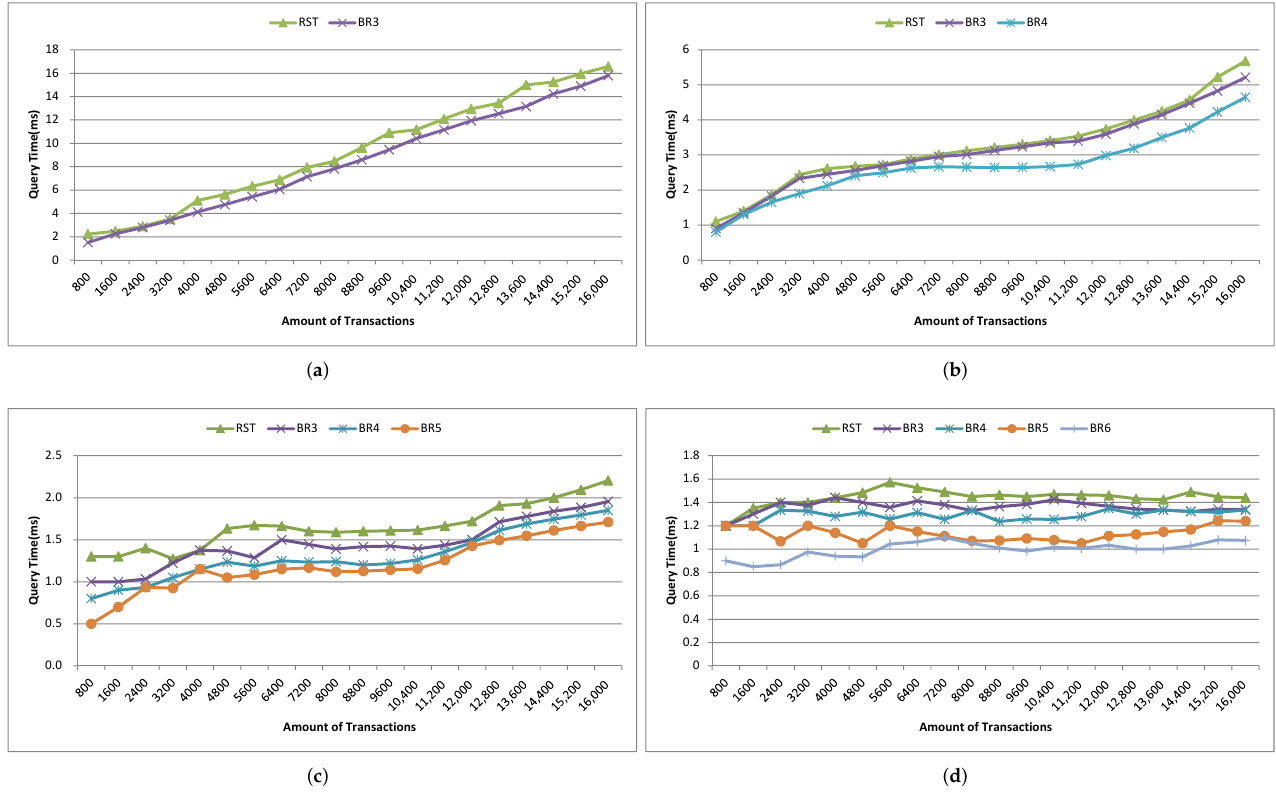
Figure 9. Query time of the amount of branch region query method with different amount of transactions in specified geographic region. ( a ) The query range is geographic region of the 3-byte Geohash encoding. ( b ) The query range is geographic region of the 4-byte Geohash encoding. ( c ) The query range is geographic region of the 5-byte Geohash encoding. ( d ) The query range is geographic region of the 6-byte Geohash